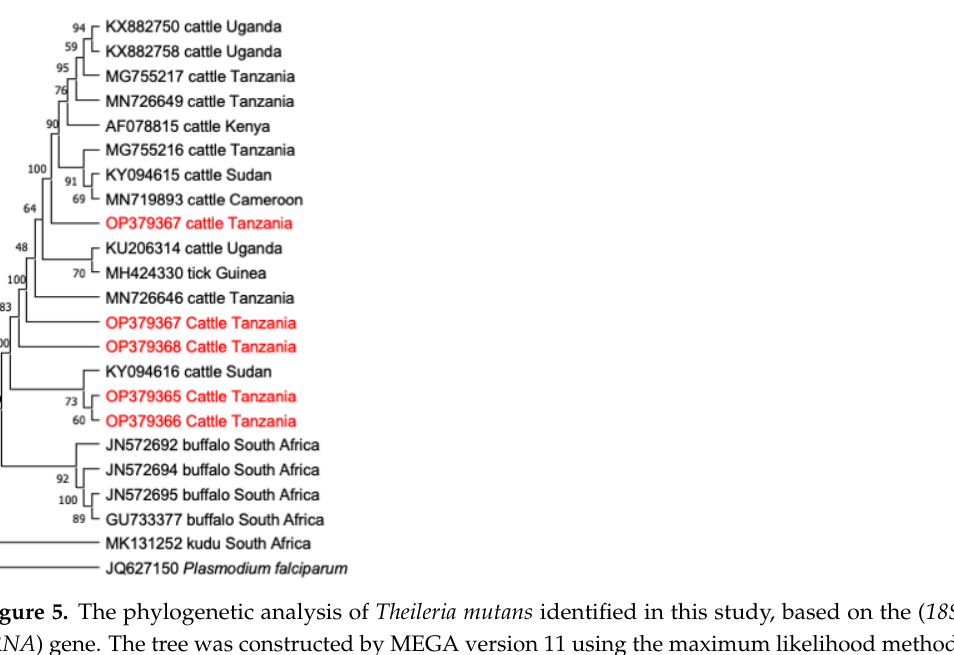
Figure 4. The phylogenetic analysis of Anaplasma marginale identified in this study, based on the ( groEL ) gene. The tree was constructed by MEGA version 11 using the maximum likelihood method, the confidence of occurrence of the nodes was assessed by bootstrap in 1000 replications. The se- quences of this study are shown in red. Anaplasma centrale (KY305557) was used as an outgroup.